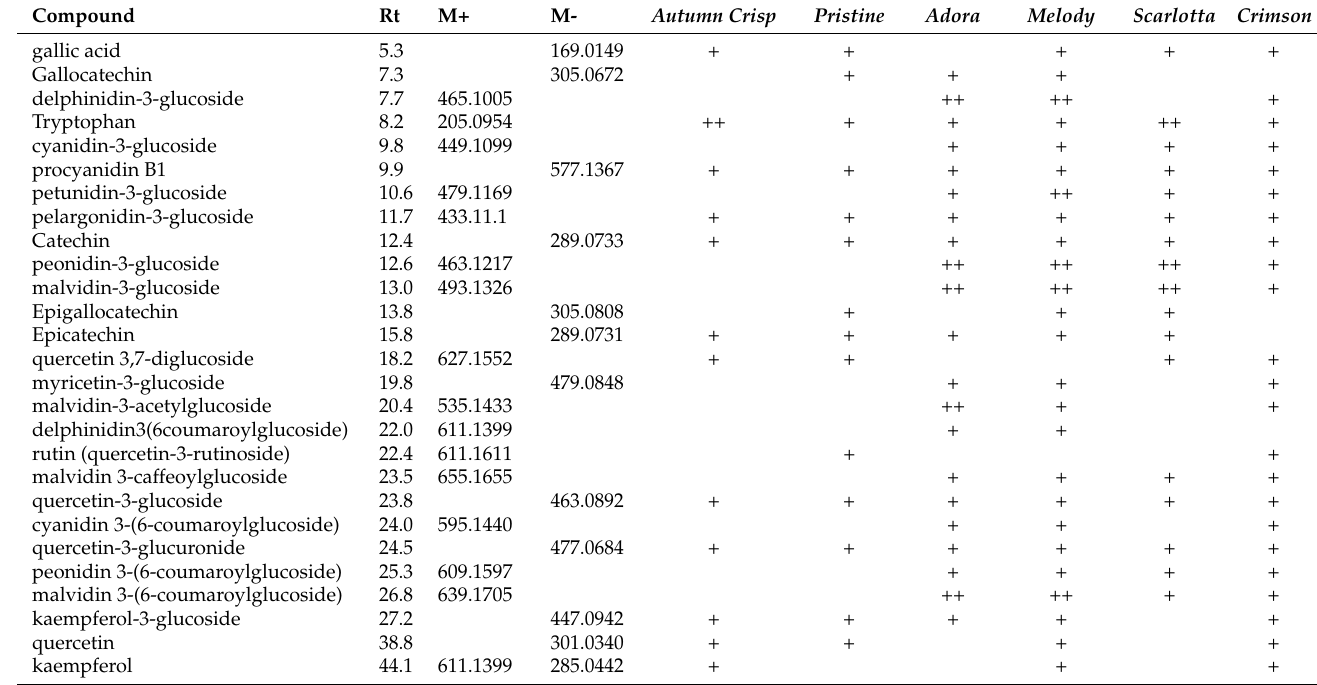
Table 1. Seedless grapes composition by